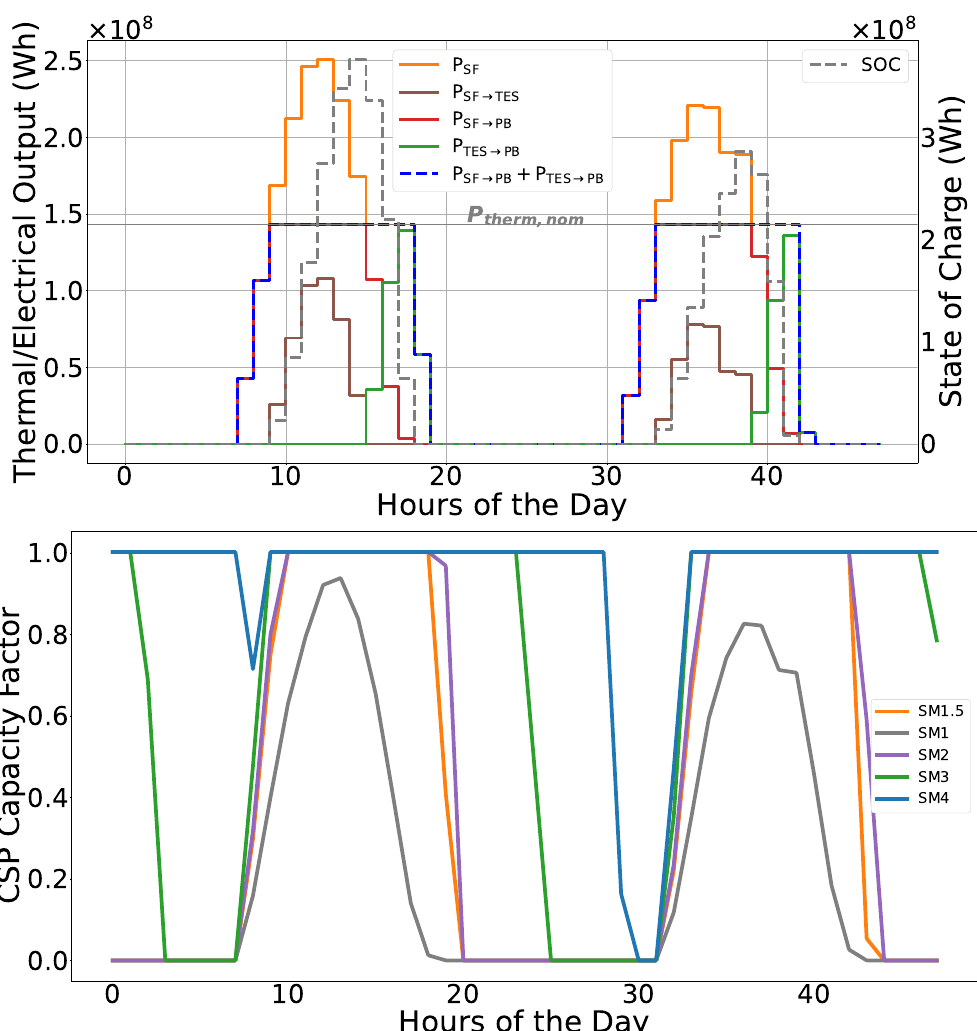
Figure 1. Top : Time evolution of the thermal energies: Solar Field energy ( P SF ), Energy from Solar Field to Power Block ( P SF → PB ), Energy stored ( P SF → TES ), Energy discharged ( P TES → PB ) and Total available energy injected to the Power Block ( P in = P SF → PB + P TES → PB ) and the State of charge (SOC) for a Solar Multiple (SM) of 1.5. Bottom : Capacity factors for SMs of 1, 2, 3 and